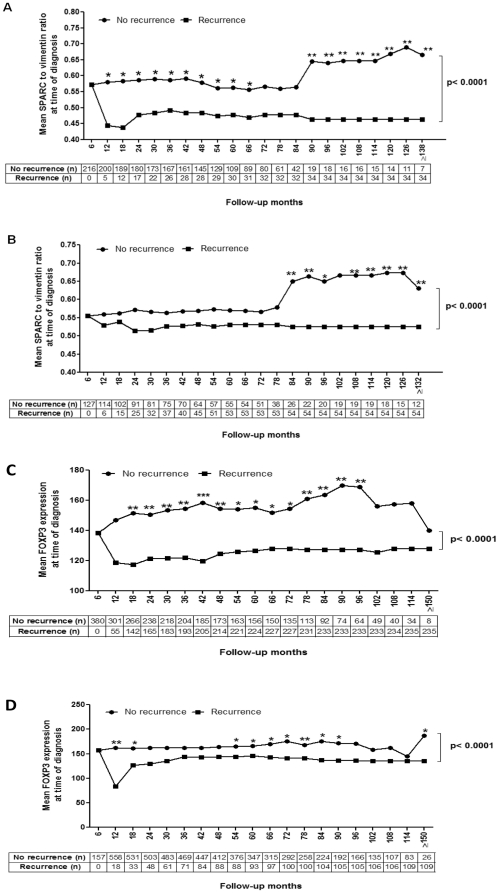
Cancer-specific survival.The mean SPARC and FOXP3 expression in the primary tumour was measured and correlated with disease recurrence. The number of patients with or without disease recurrence at each time point is displayed below each graph. (A) SPARC expression in stage II CRC
. Patients without disease recurrence had significantly higher SPARC levels at all time point up to 60 months and for most points up to 138 months compared to those patients who suffered a disease recurrence. The overall SPARC expression was significantly different between the two groups (p<0.0001). (B) SPARC expression in stage III CRC
. SPARC expression was significantly higher in patients without disease recurrence from 84 months and beyond. SPARC was also significantly different between the two groups (p<0.0001). (C) FOXP3 expression in stage II CRC
. Higher FOXP3 levels was also significantly associated with less disease recurrence as with (D) FOXP3 expression in stage III CRC
, however, the differences were not as marked as in stage II CRC. FOXP3 expression was significantly different between the two groups in both stage II and III (p<0.0001). Each data point represented the mean SPARC or FOXP3 expression level at each time point. (*) p<0.05, (**) p<0.01.